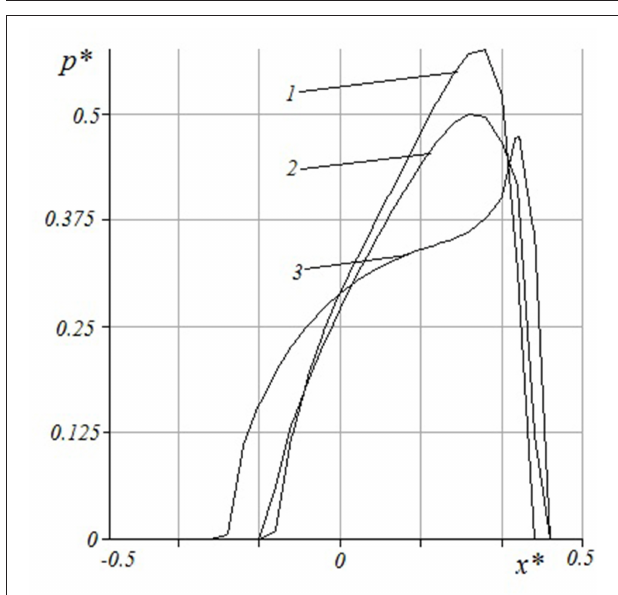
FIGURE 5 | Dependence of maximum pressure value on layer thickness ( c = 5, ν = 0.3, Q ∗ = 0.1, V ∗ = 1 / 60).